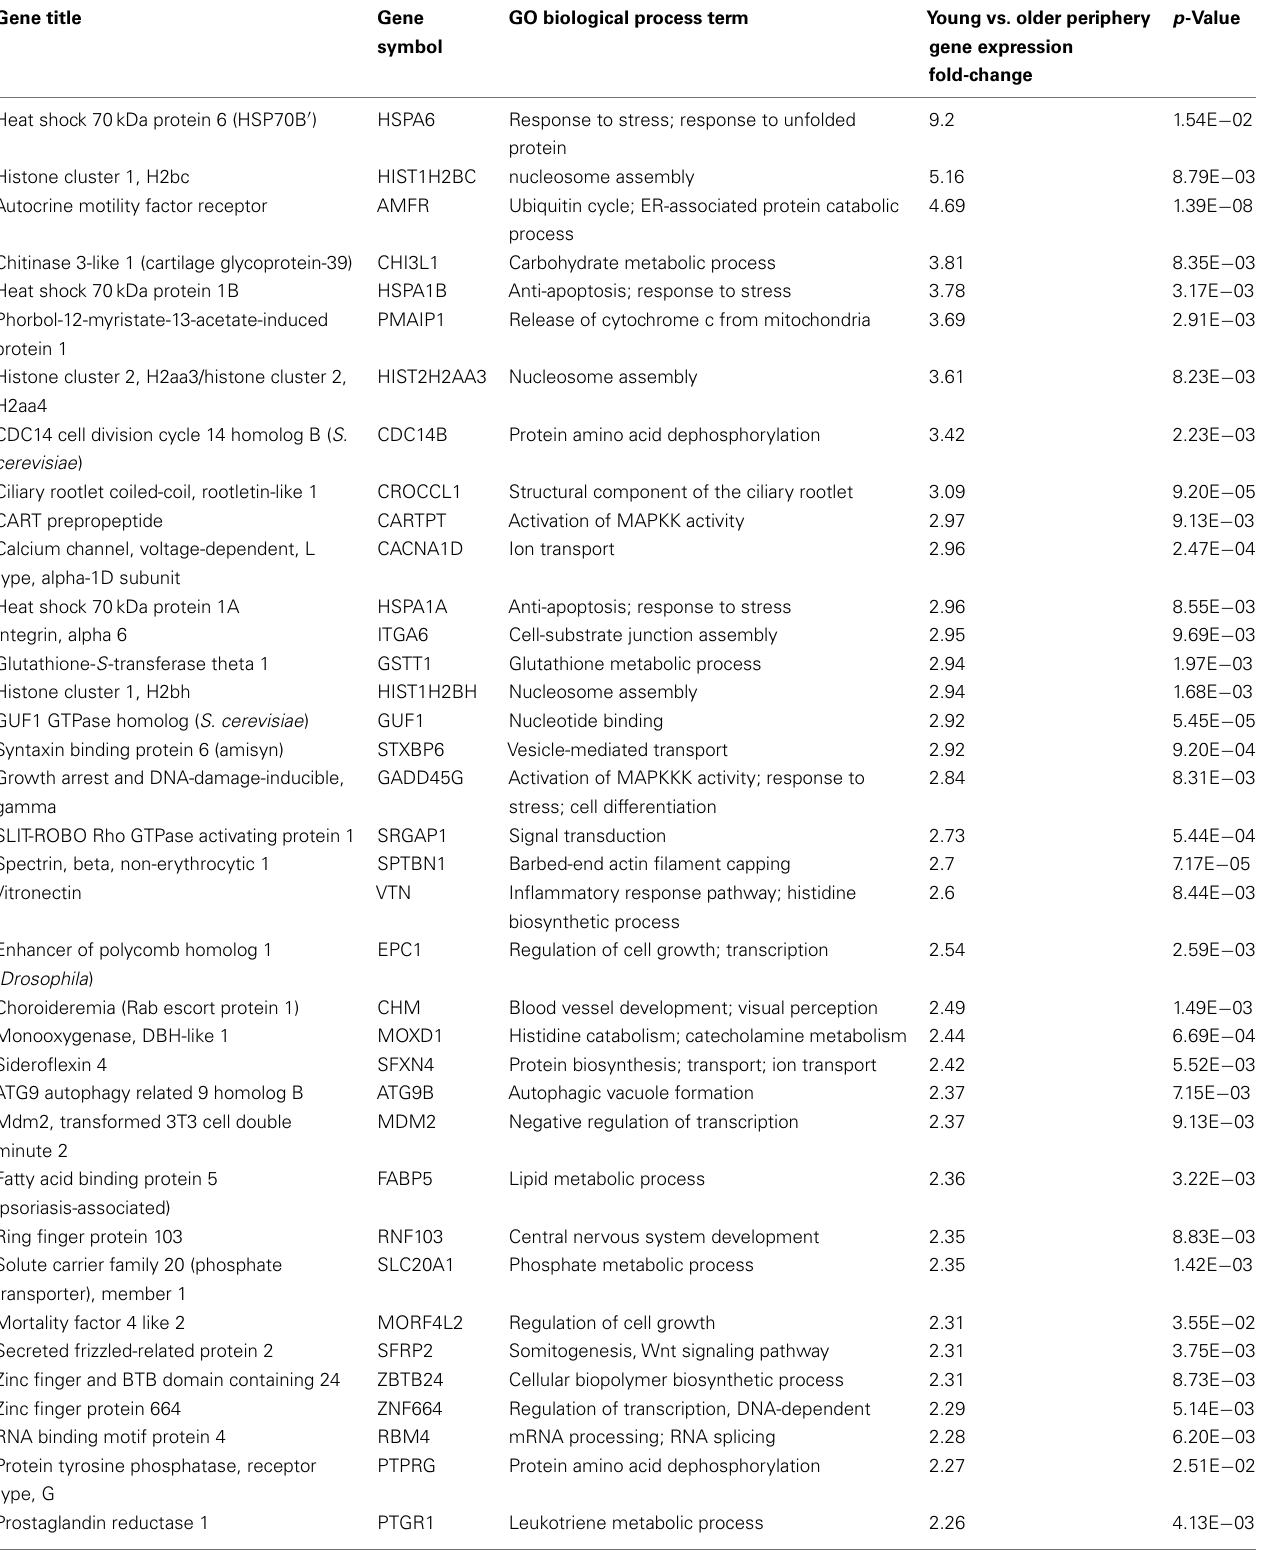
Table 7 | Genes highly expressed in young compared to old peripheral